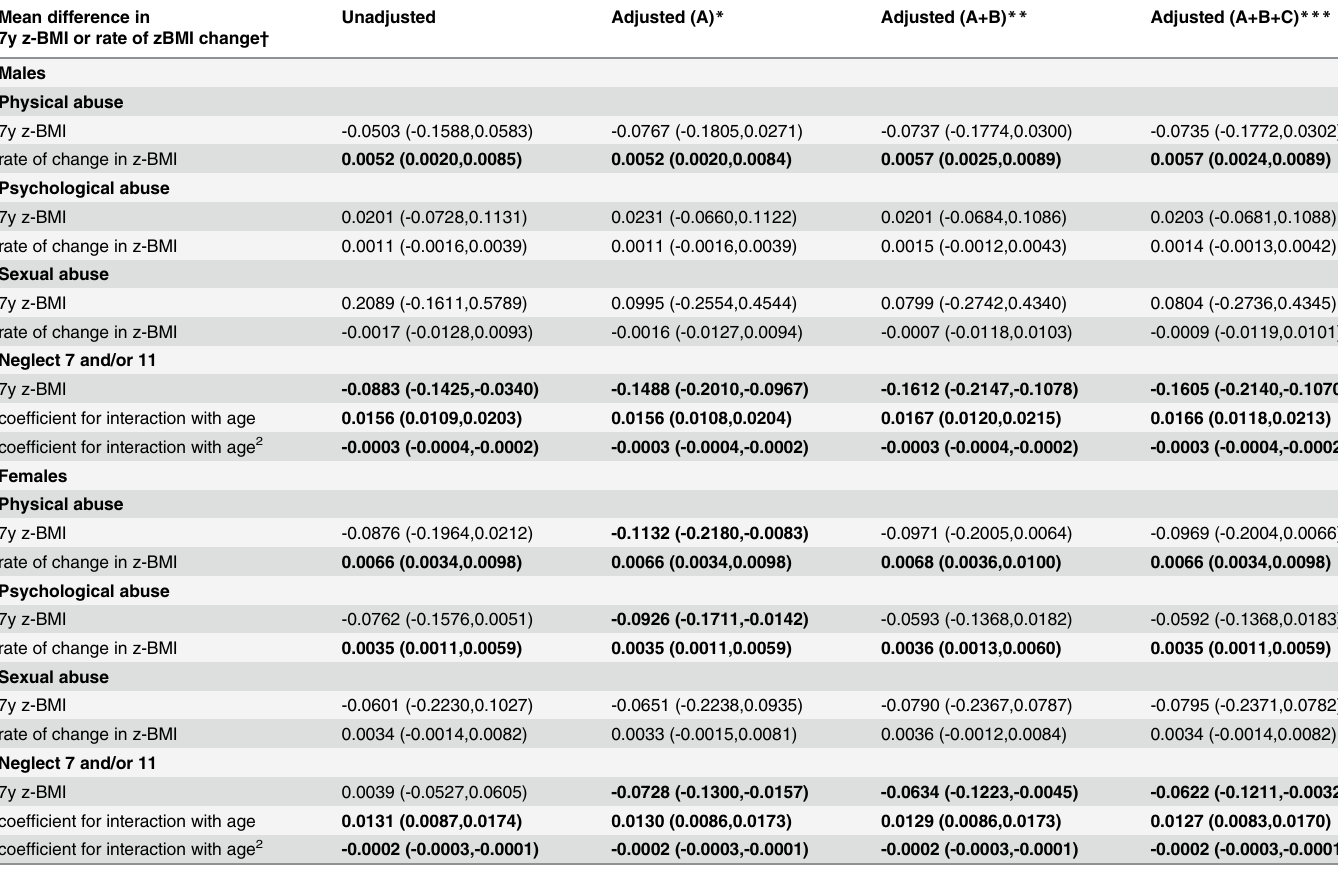
Table 4. Mean differences in zBMI (95% CIs) at 7y and rate of change in zBMI (7 – 50y) by childhood maltreatment, estimated using multilevel